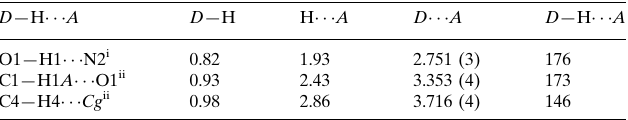
Hydrogen-bond geometry (A˚ , (cid:2)